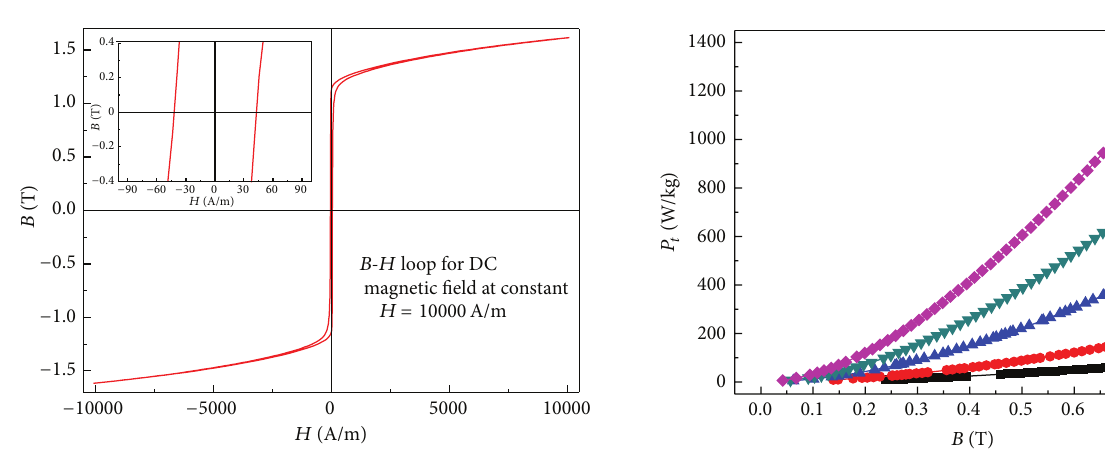
Figure 6: Static hysteresis loop of melt spinned ribbons after heat treatment (1100 ∘ C/5h + FC).